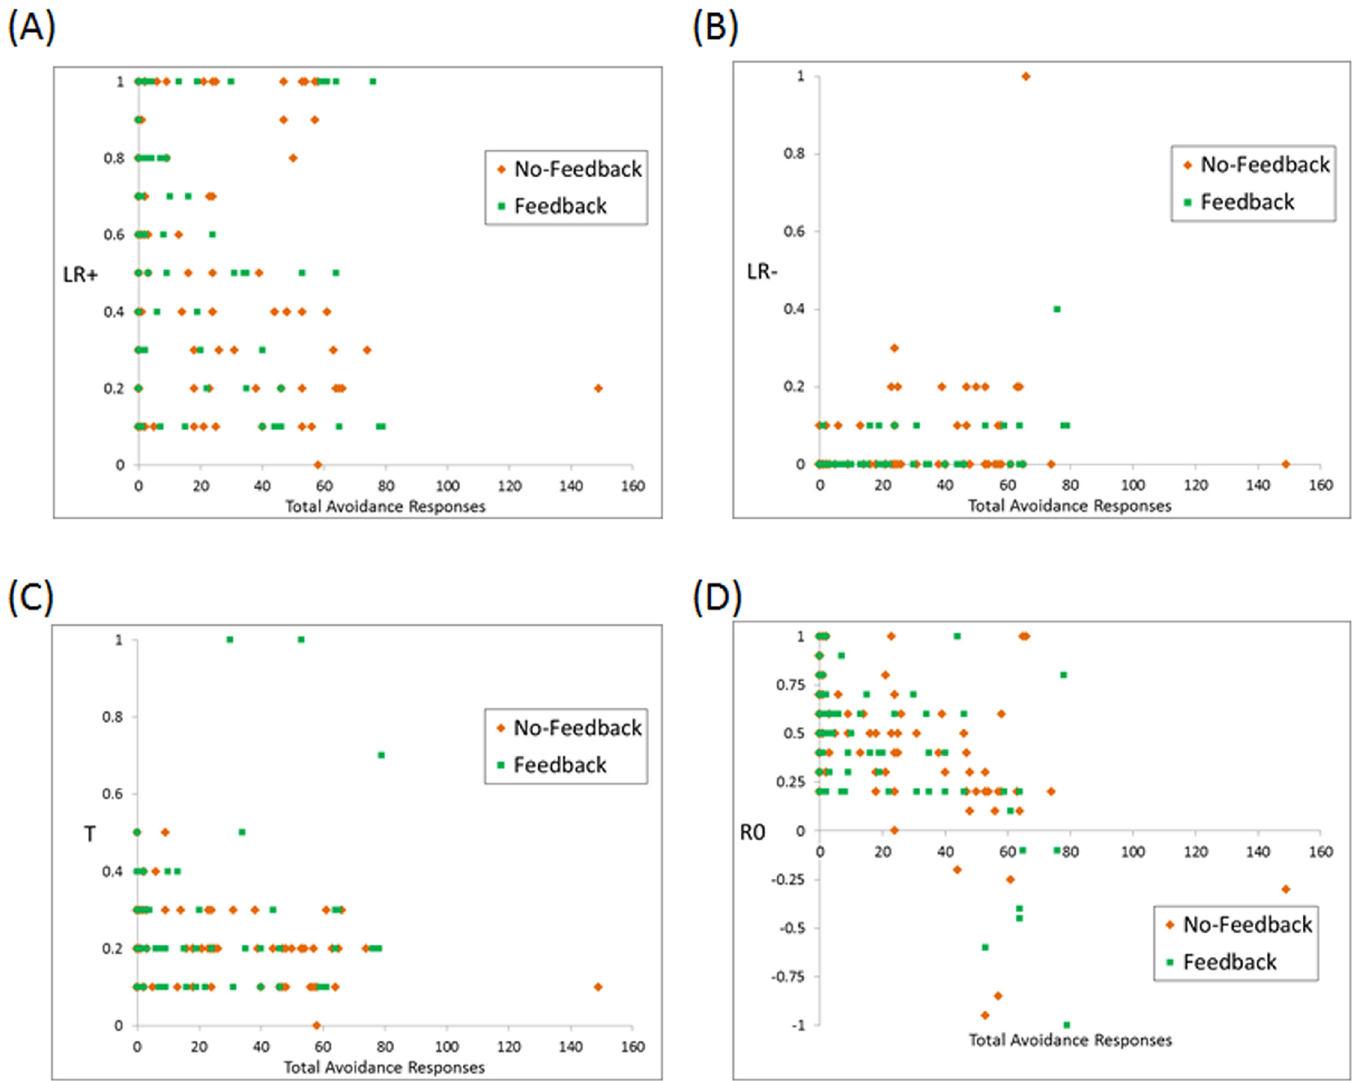
Fig 6. Correlations between avoidance behavior and estimated parameter values (A) LR+ , (B) LR- , (C) T , (D) R0 . LR - was positively correlated with avoidance responses, indicating that subjects who made more avoidance responses tended to learn more quickly from worse-than-expected feedback; R0 was negatively correlated with avoidance responses, indicating that subjects who made more avoidance responses tended to more negatively value the ambiguous neutral feedback on categorization